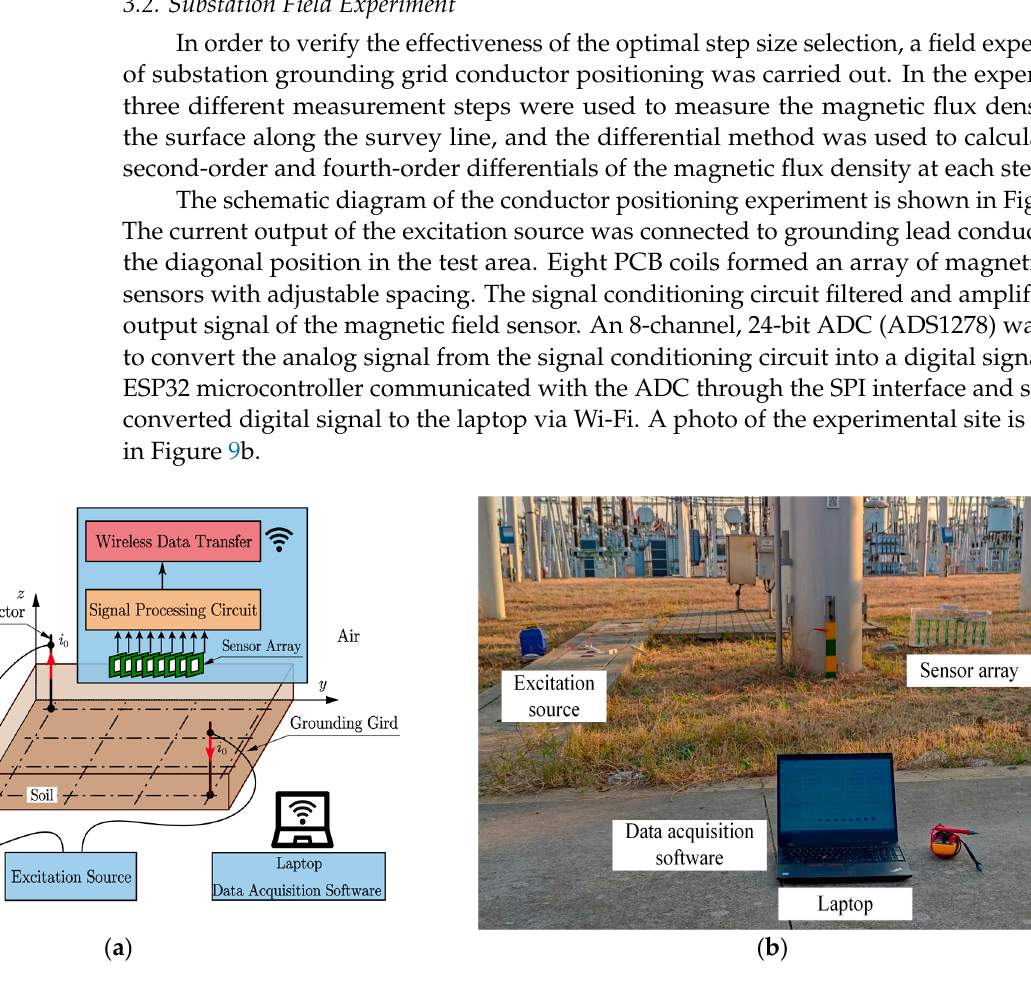
Figure 9. The 500 kV substation field experiments: ( a ) schematic diagram of conductor positioning experiment; ( b ) field experiment photo.